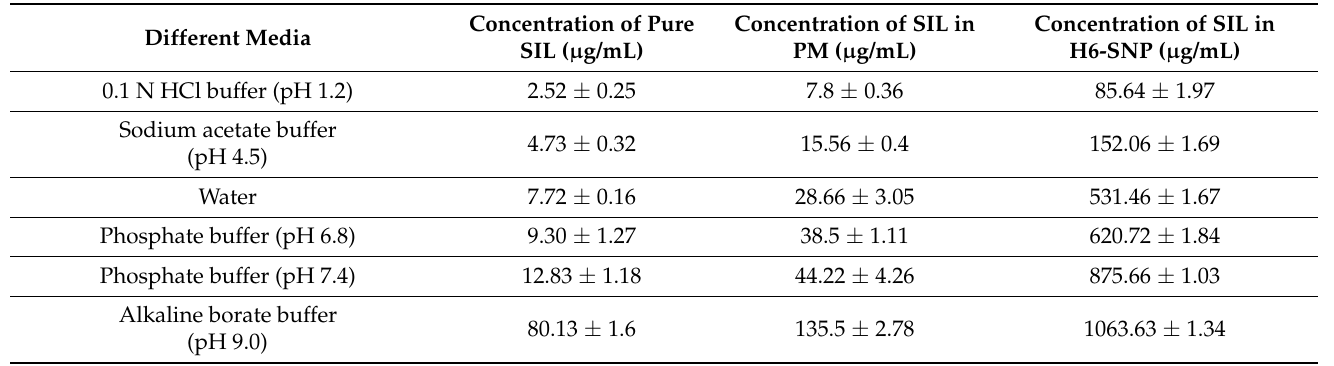
Table 6. Equilibrium solubility studies of SIL, PM and H6-SNP in water and different pH